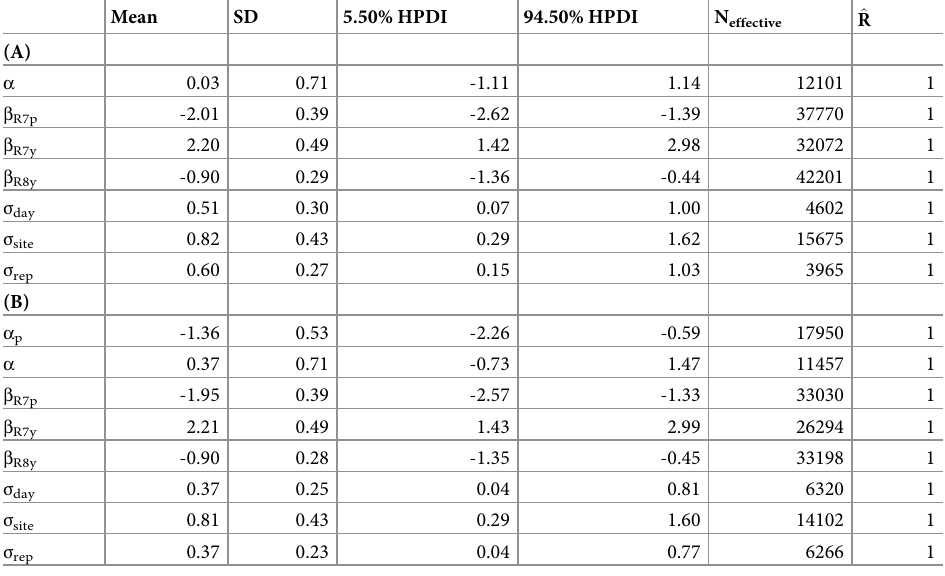
Table 10. A summary of posterior distributions for the coefficients estimated by analysis of new data collected in Uganda, incorporating priors from the analysis of data collected in Kenya that itself used informative priors. Coefficients are displayed for (A) over-dispersed Poisson, and (B) zero-inflated over-dispersed Poisson models. Mean SD 5.50% HPDI 94.50% HPDI